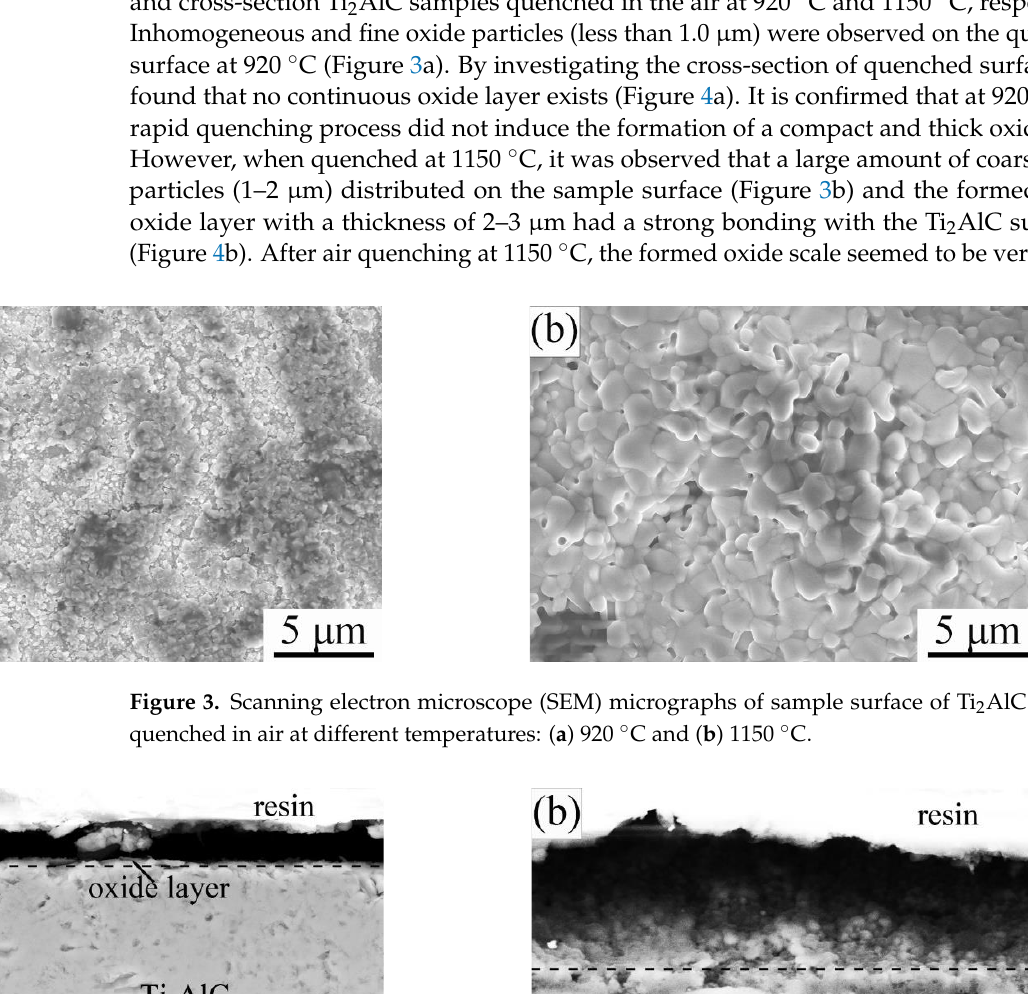
Figure 1. X-ray diffraction (XRD) patterns of Ti 2 AlC samples quenched in air at different tempera- ture: ( a ) 25 °C, ( b ) 480 °C, ( c ) 920 °C, and ( d ) 1150 °C. Figure 2. Energy dispersive spectrometer (EDS) patterns of Ti 2 AlC samples quenched in air at dif- ferent temperatures: ( a ) 920 °C and ( b ) 1150 °C.